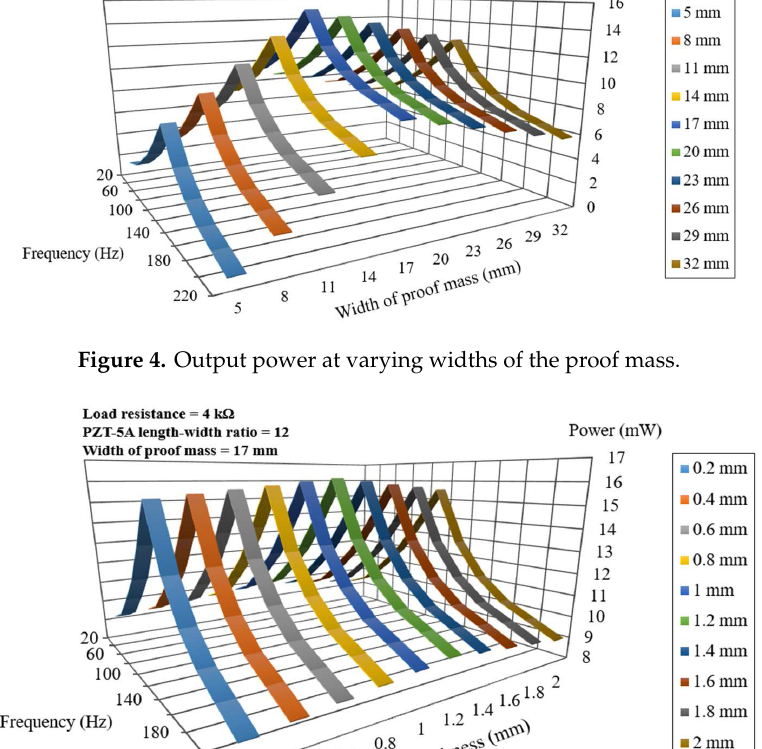
Figure 5. Output power at varying thickness of PZT-5A.